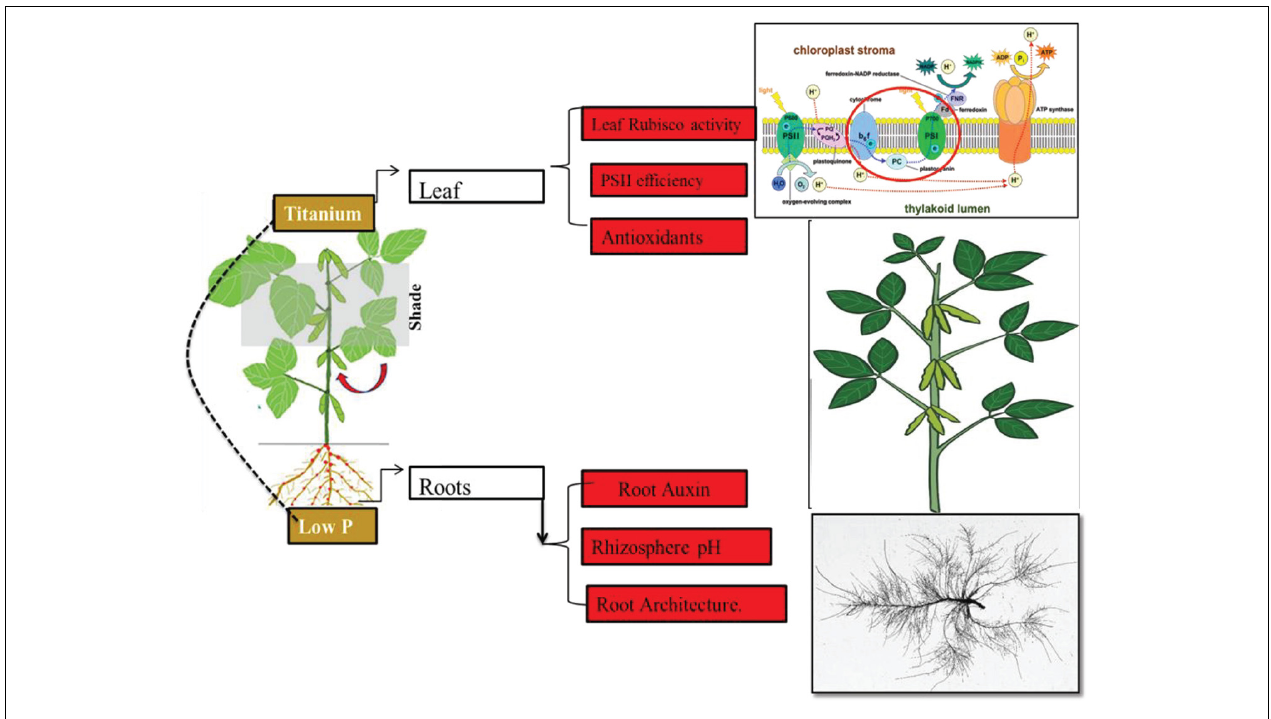
FIGURE 15 | Mechanisms for increase in P uptake after Ti